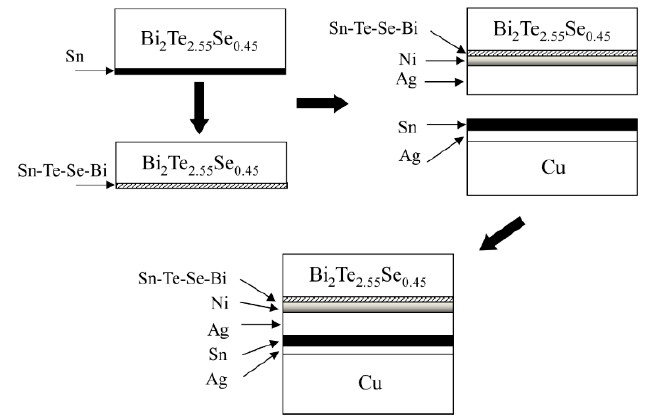
diffusion-soldered specimen was determined to signify the intermetallic thickness ( X ).